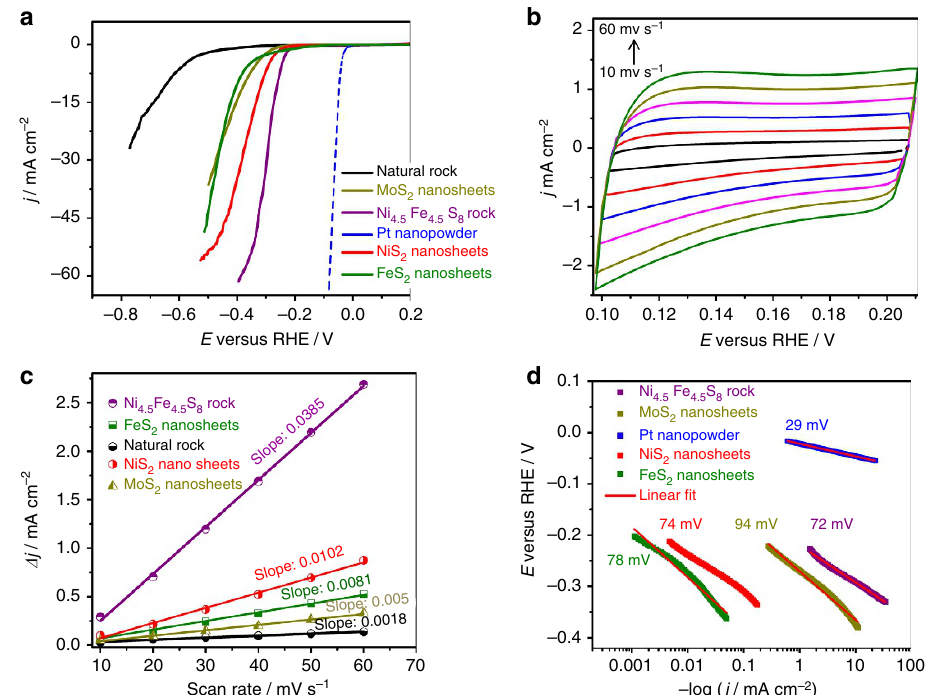
Figure 3 | Electrochemical characterization. ( a ) Linear sweep voltammograms of the catalysts recorded at a sweep rate of 5mVs (cid:2) 1 in 0.5M H 2 SO 4 . The diffusion limited current density was normalized to the geometric area of the electrodes. ( b ) Cyclic voltammograms for the synthetic pentlandite and ( c ) charging current density differences ( D j ¼ j a (cid:2) j c ) as a function of the scan rate. The linear slope is equivalent to twice of the double-layer capacitance C dl , representing the electrochemical surface area (ECSA). ( d ) Tafel plots derived from voltammograms at a sweep rate of 1mVs (cid:2) 1